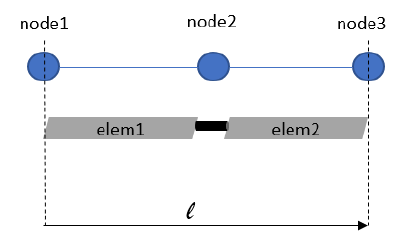
Figure 12. Graphic comparison between finite segment and finite volume modeling of a flexible element of free-length l .